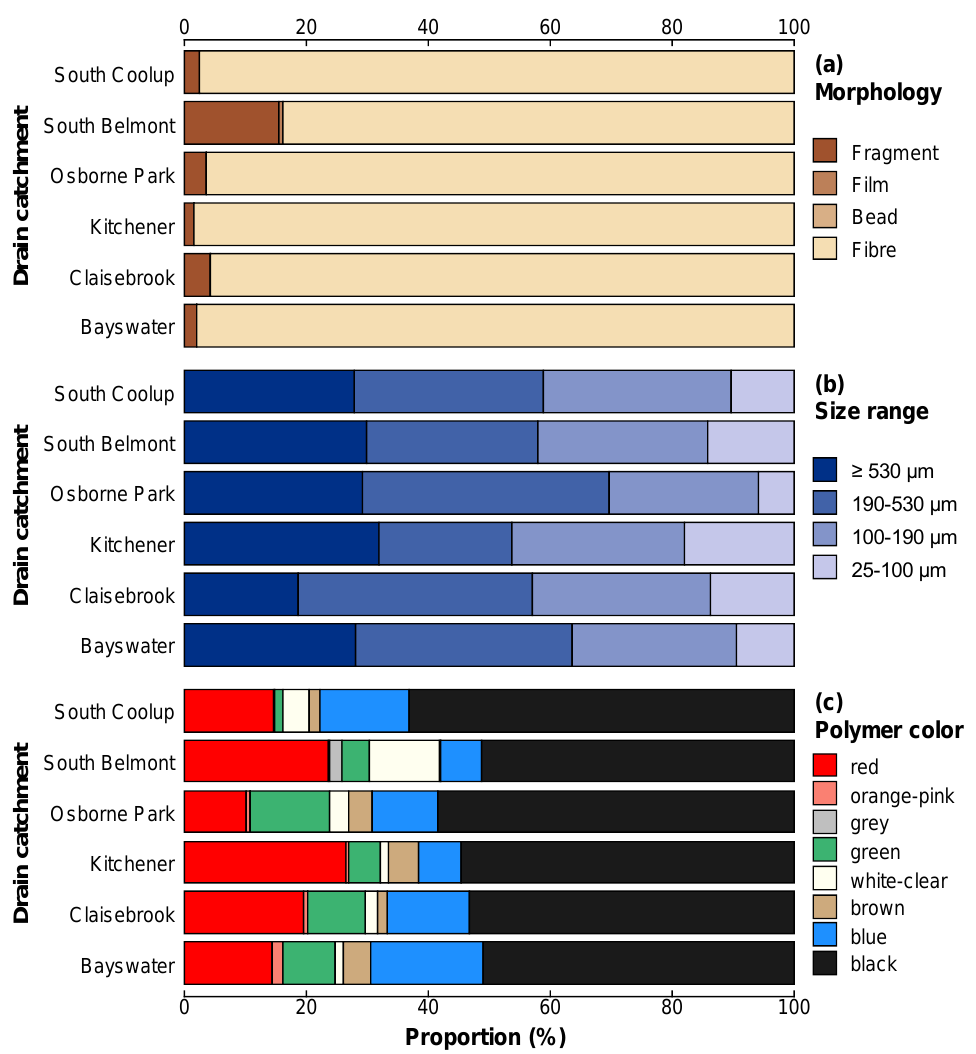
Figure 5. Proportions of microplastics in each catchment, classified by ( a ) shape (morphology), ( b ) size, and ( c ) colour. Size . Microplastics in the 190–530 µ m size category were the most abundant (33%), followed by 100–190 µ m (28%), ≥ 530 µ m (27%) and 25–100 µ m (12%). Kitchener and South Belmont were the only drainage catchments having the ≥ 530 µ m size category as the most populous size fraction, comprising 32% (K) and 30% (SB) of plastics identified. Kitchener and South Belmont catchments also featured the greatest proportion of 25–100 µ m polymers, at 18% (K) and 14% (SB). Colour . The majority of microplastics identified were black (55%), followed by red (18%), blue (12%) and green (7%) (Figure 5c). Pink, orange, brown, clear, white and grey microplastics each represented less than 5% of the total microplastic count. The proportions of microplastics of different morphologies are shown in Figure 5a, different sizes in Figure 5b, and different colours in Figure 5c. Additionally, a subsample of the microplastics identified are presented in Figure